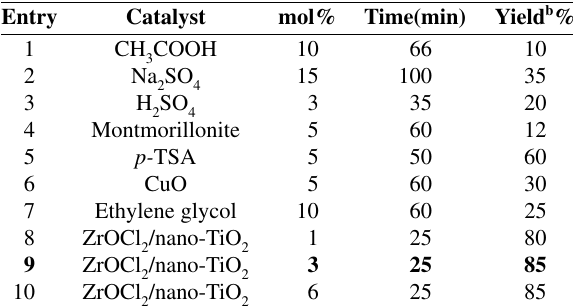
Table 1. The model reaction carried out by various catalysts under solvent-free conditions at 100 ° C a